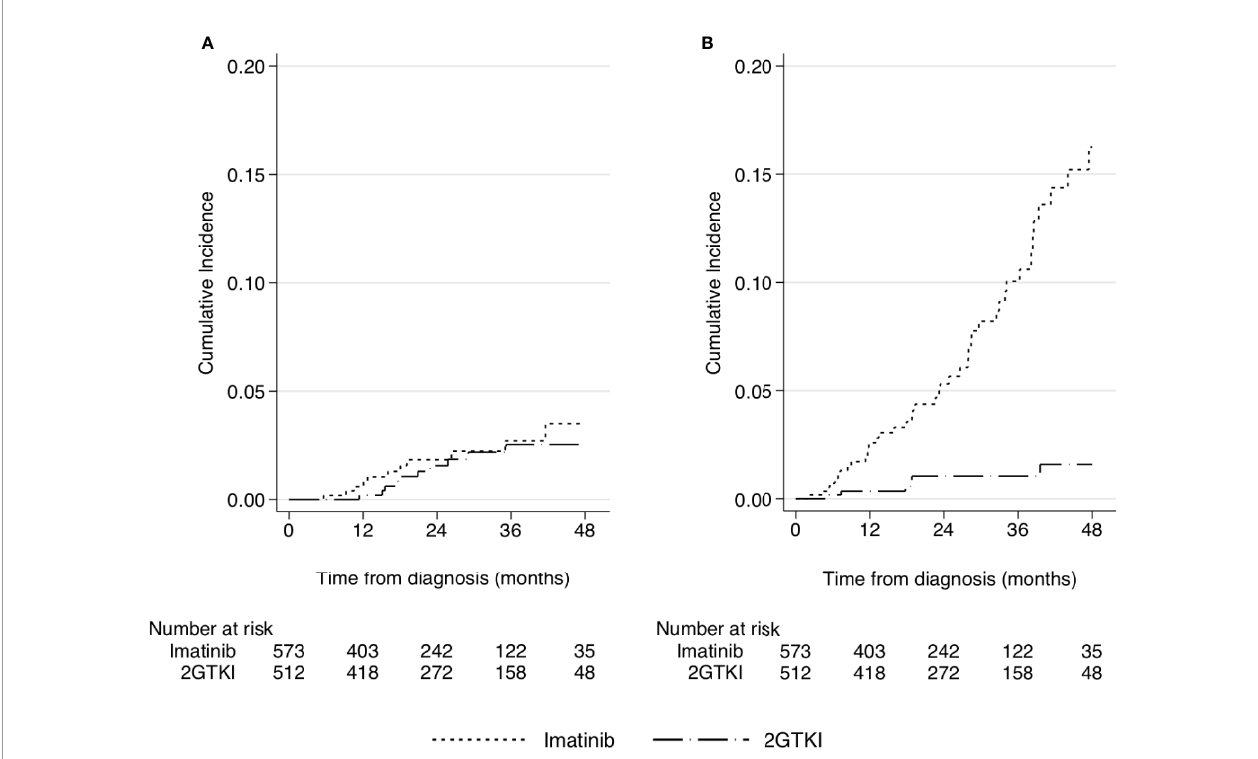
FIGURE 2 | Cumulative incidence of mortality related to CML (A) or to other causes of deaths (B) treated as a competing event, according to front-line TKI